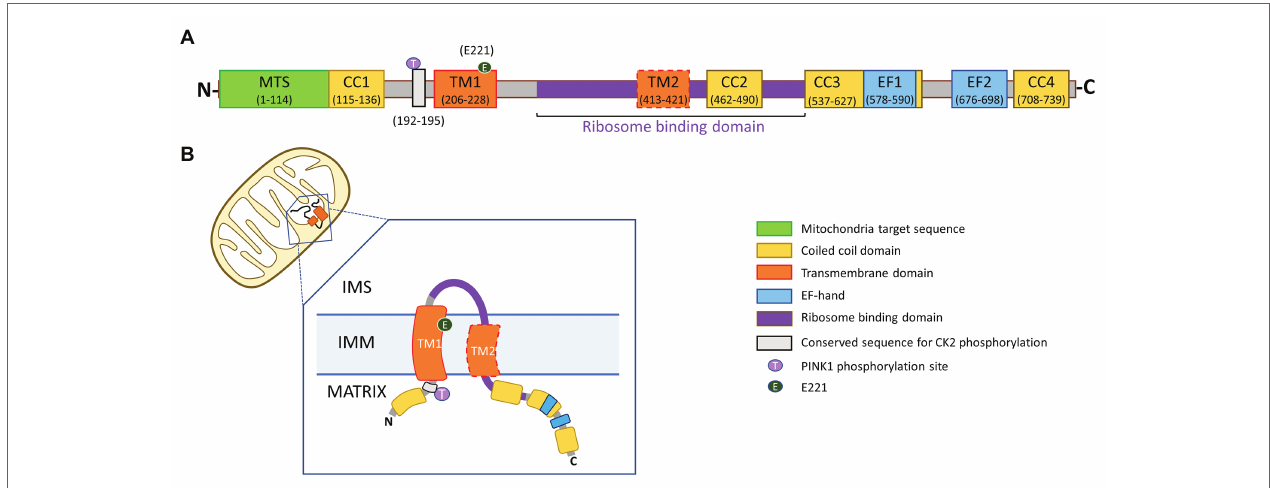
FIGURE 1 | Proposed topology of leucine-zipper EF-hand containing transmembrane 1 (LETM1). (A) Domain architecture of LETM1. MTS, mitochondrial targeting sequence; CC1, CC2, CC3, and CC4, coiled-coil domains 1–4; TM1, conserved transmembrane domain 1; TM2, putative transmembrane domain 2; EF1, EF2, non-canonical Ca 2+ -binding EF-hand domains; and Gray Box – TXXR motif, a conserved consensus site for phosphorylation by protein kinase C and casein kinase 2 (CK2). The numbers in parentheses represent amino acid residue for human LETM1 sequence (Uniprot accession number: Q2VYF4). (B) Both the N- and C-termini of the LETM1 subunit are proposed to reside in the mitochondrial matrix. A portion of the ribosome binding domain is exposed to the inter-membrane space